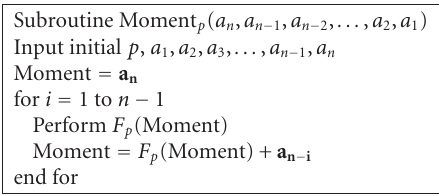
Algorithm 1: The algorithm for computing 1D moments.